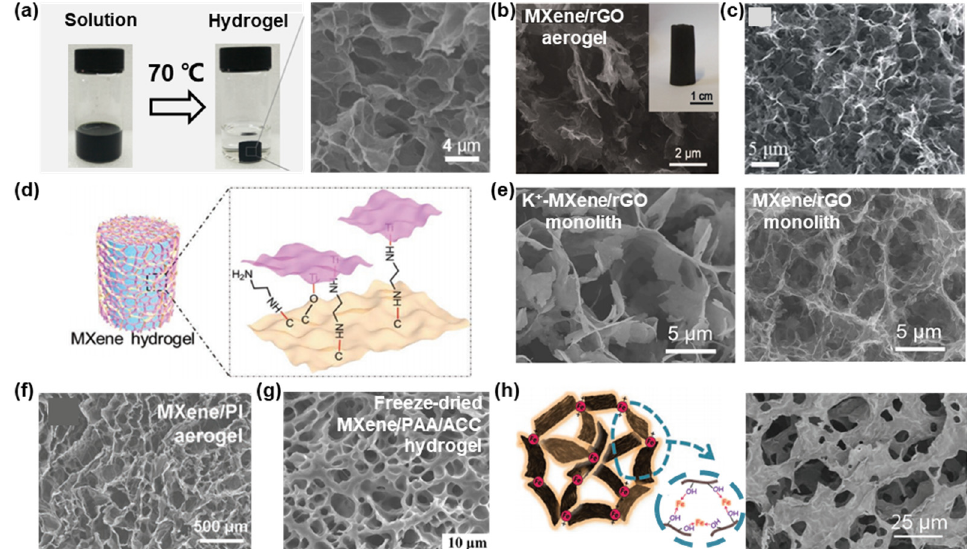
Figure 4. Digital photographs and SEM images of MXene/rGO ( a ) hydrogel and ( b , c ) aerogels with isotropic cellular microstructure. ( d ) Schematic illustration of EDA-MXene/rGO